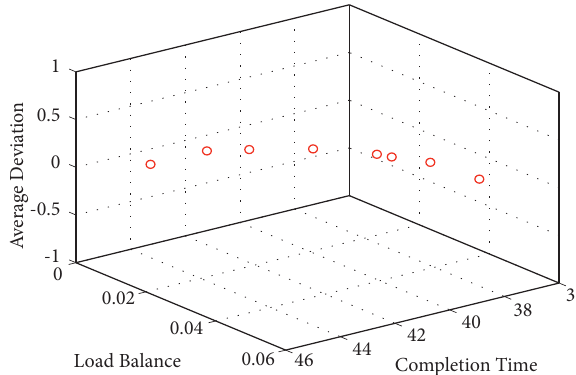
Figure 5: Nondominated graph for the optimization of tasks to be processed at t � 30.